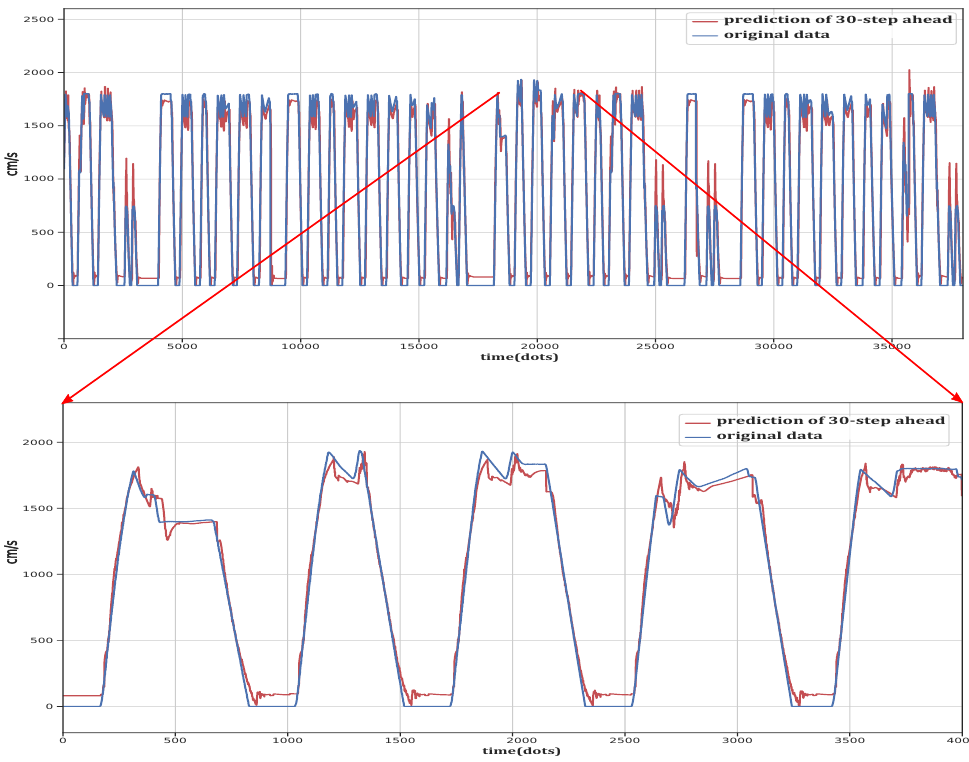
Figure 9. Comparison of the original data and the output of 30-step-ahead